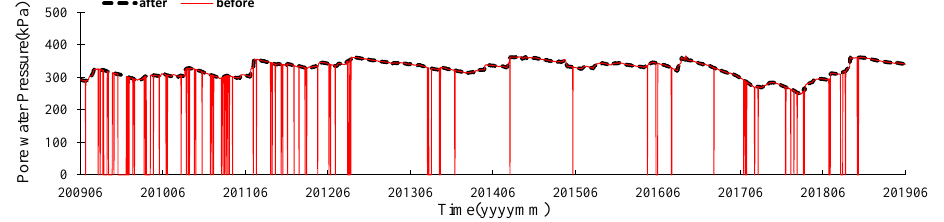
Figure 5. Linear interpolation for porewater pressure.